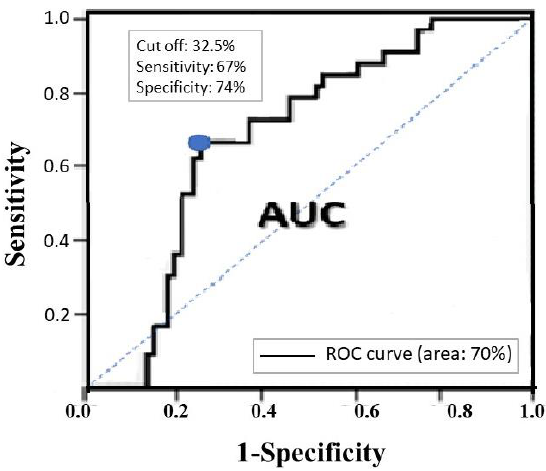
Figure 4. ROC curve for non-union. ROC analysis revealed that the summation of sensitivity and specificity was the greatest at the point indicated by the blue circle; it corresponds to a ratio of the unfixed distal segment that is 32.5% of the main distal fragment length.